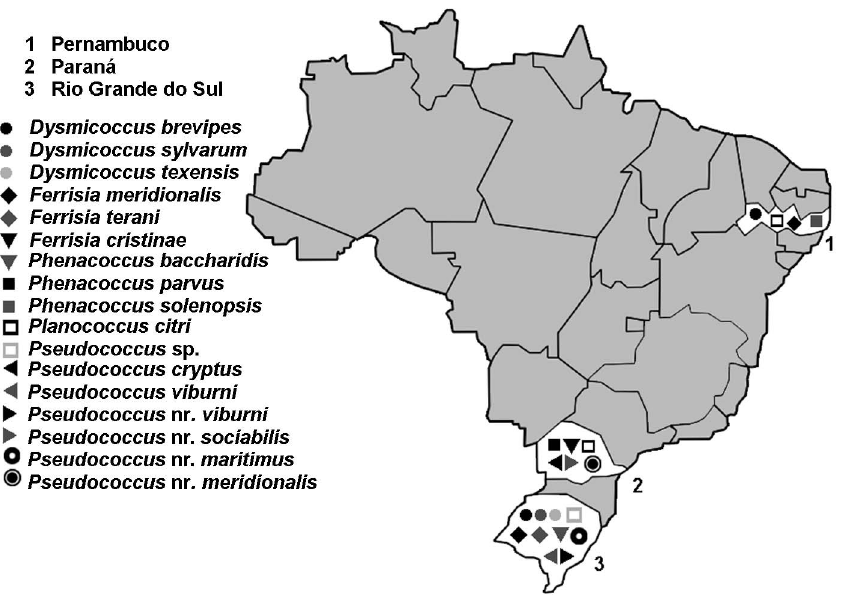
Figure 2. Distribution of mealybug species in vineyards in the Parana´, Pernambuco and Rio Grande do Sul states (Brazil).